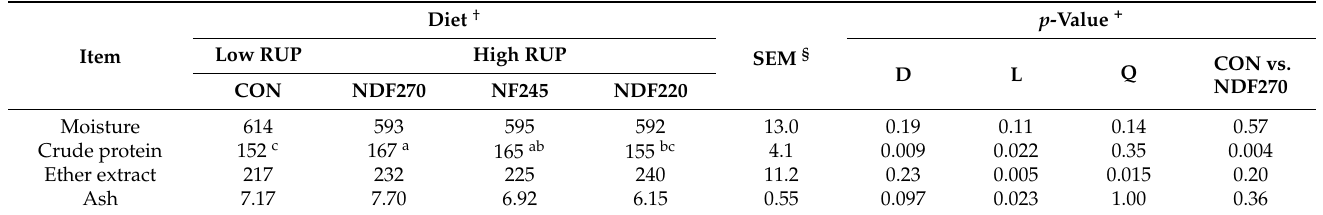
Table 8. Chemical composition (g/kg as is ) of deboned carcasses of finishing lambs fed different levels of dietary neutral detergent fiber (NDF) and high rumen undegradable protein